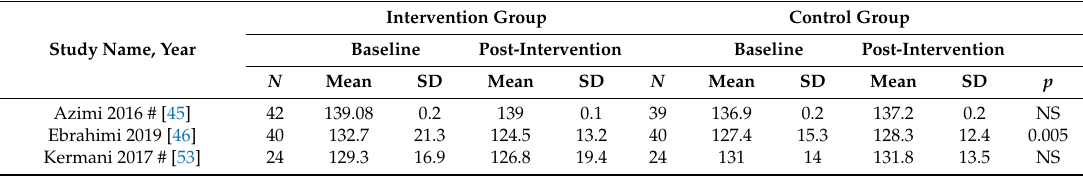
Table 8. Summary of findings for systolic blood pressure (SBP).